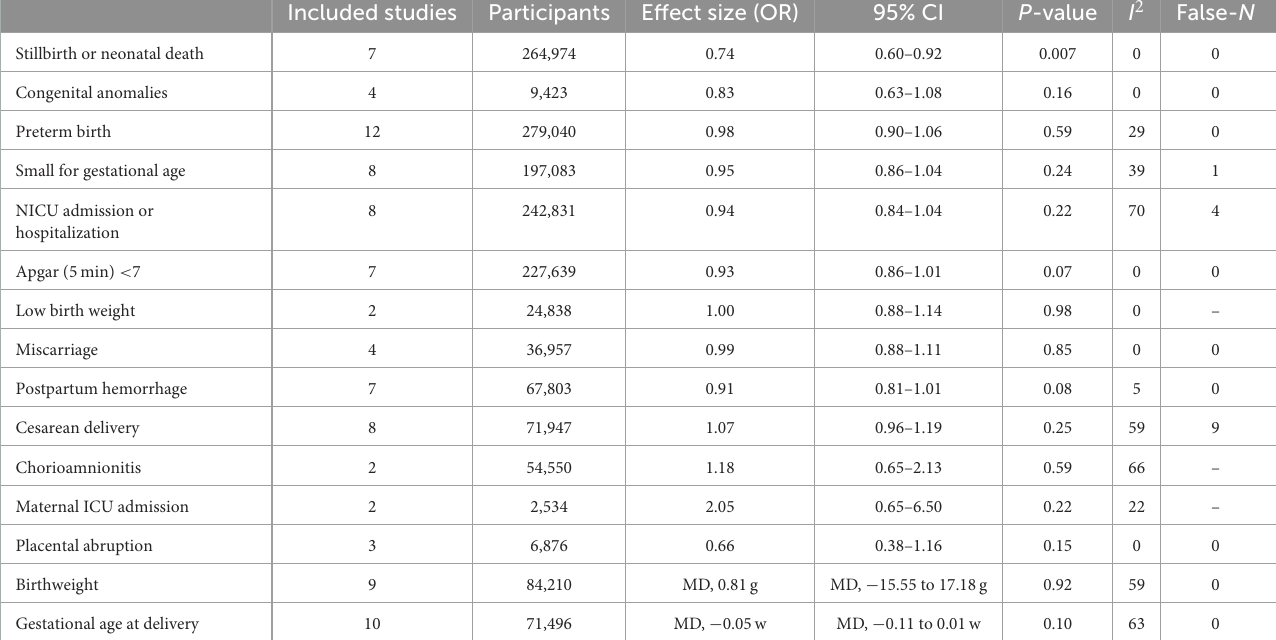
TABLE 1 Pooled results of association of COVID-19 vaccination during pregnancy and adverse birth